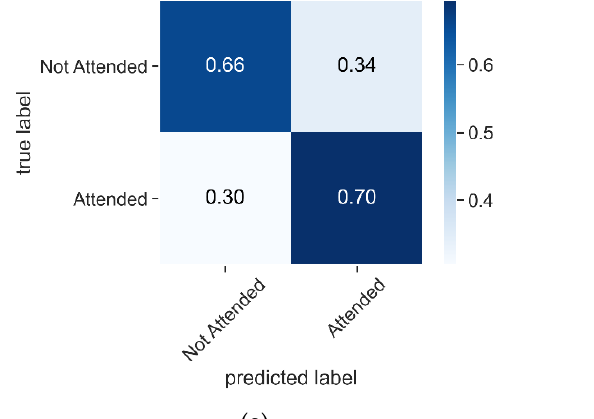
( b ) Figure 7. Dashboard views: ( a ) average attention by emotion view; ( b ) attention level by participant view. 4. Results 4.1. Analytics Results Based on the Classification Models According to the emotion and attention classification data, there are two major ana- lytic types provided for participants of the zoom meeting, as shown in Figure 7a,b: a bar